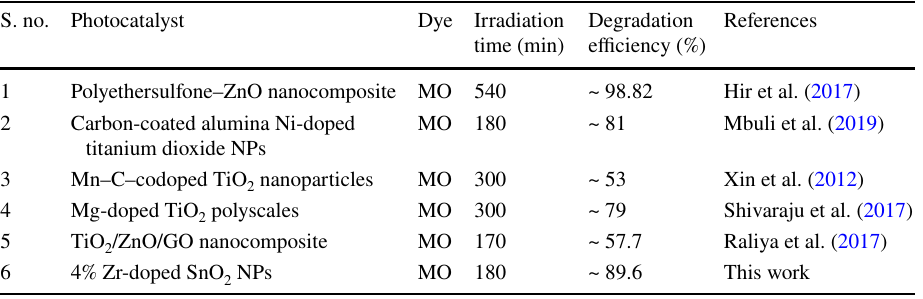
Fig. 15 Zone inhibition test for NPs towards A E. coli and B S. aureus bacteria’s